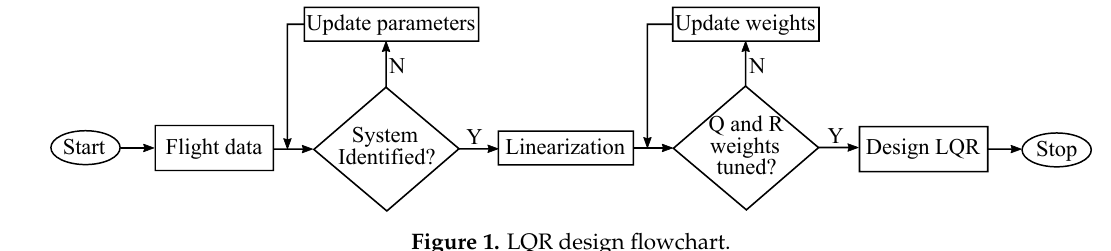
Figure 1. LQR design